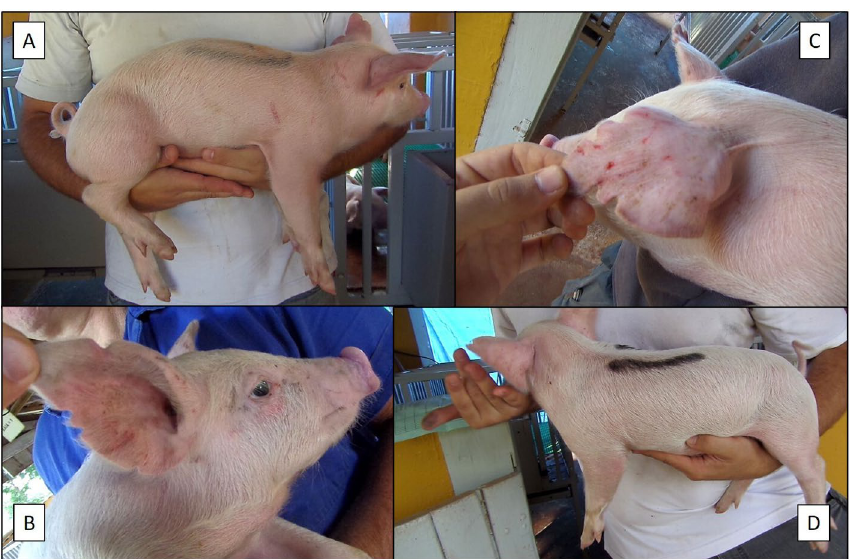
Figure 1. Examples of images used to count skin lesions. ( A ) Right lateral body; ( B ) face and right lateral ear; ( C ) back of the left ear and ( D ) left lateral